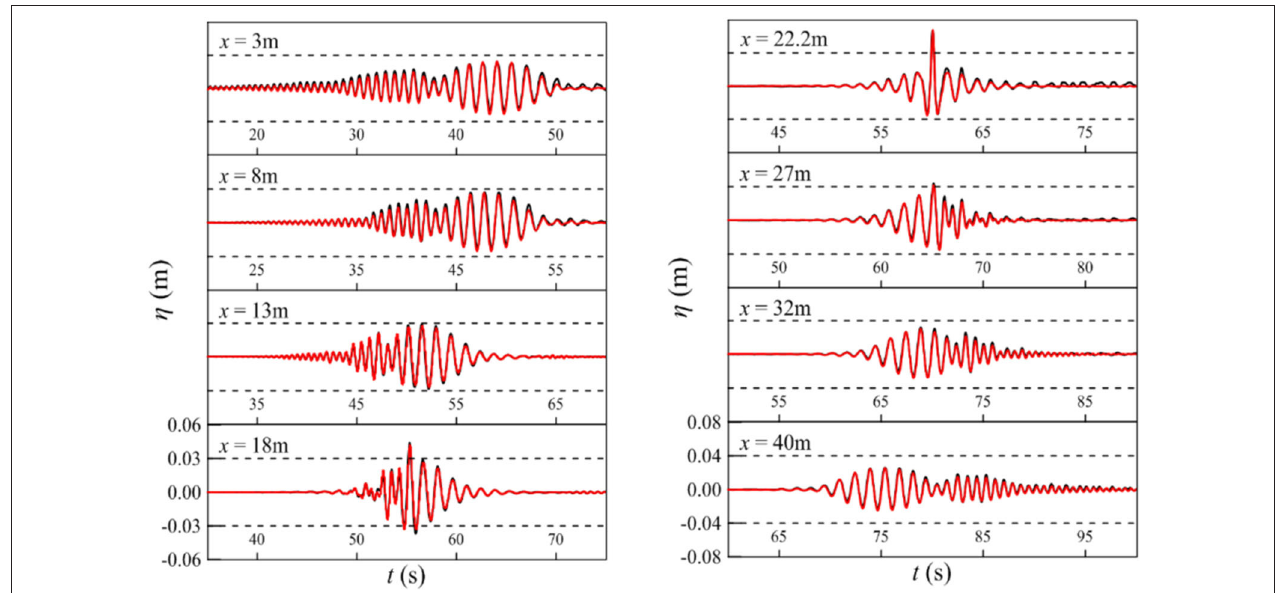
FIGURE 12 | Comparison of the free surface elevations between the numerical results and physical experimental data along the wave tank for Case 1_AB (black solid lines represent the experimental data, and red solid lines represent the numerical results).